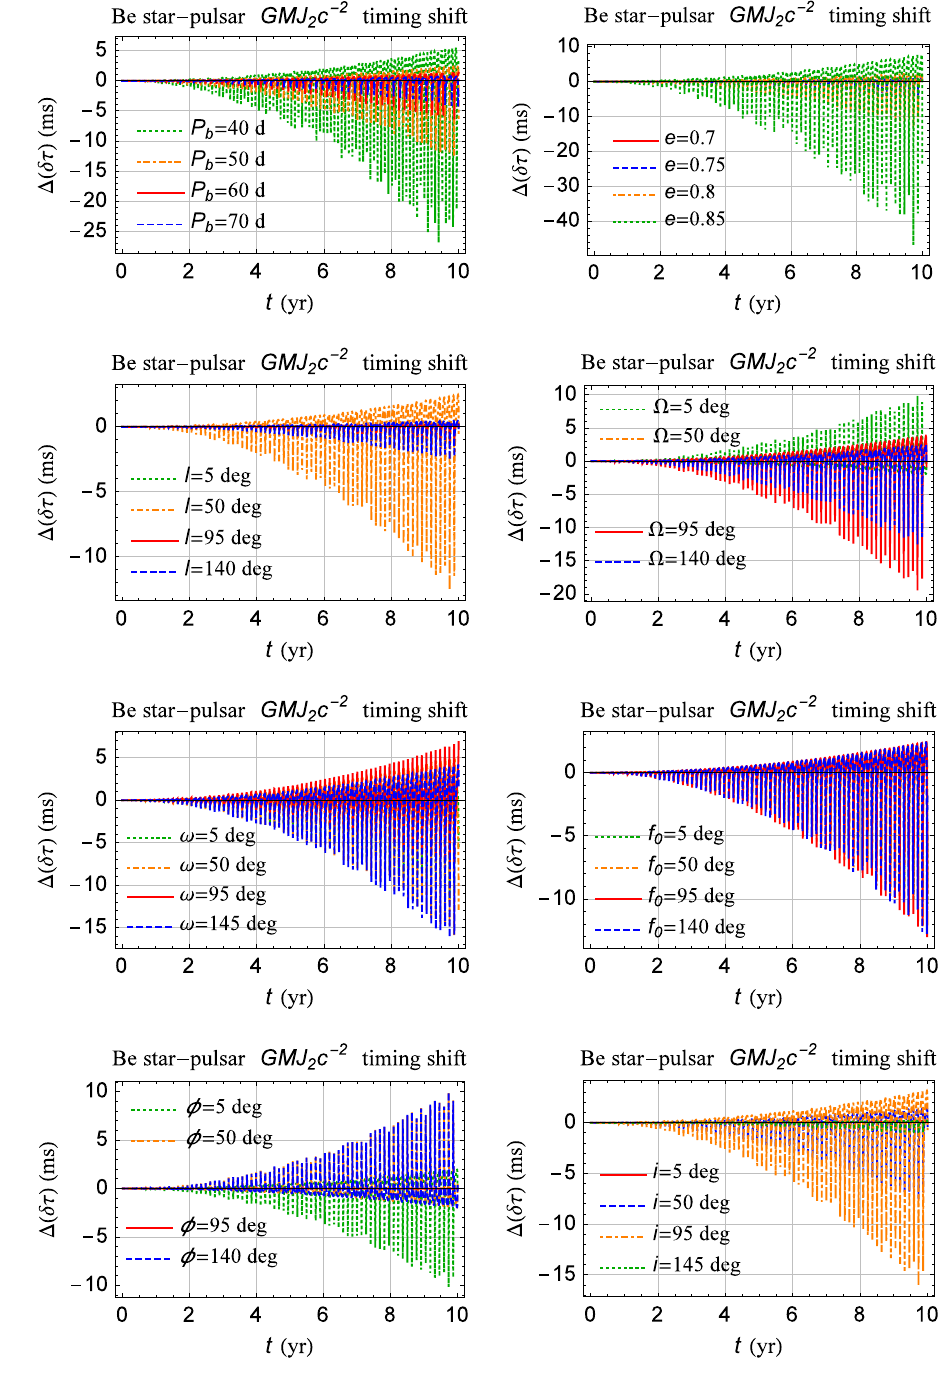
Fig. 3 Numerically integrated time series of the timing shift (cid:4)(δ τ ) due to Eq. (8), in ms, for variations of the parameter space of a fictitious binary pulsar, characterized by P b = 50 days , e = 0 . 8 , I = 50 deg , (cid:12) = 140 deg , ω = 149 deg , f 0 = 228 deg, orbiting a Be-type star with M = 15 M (cid:2) , R e